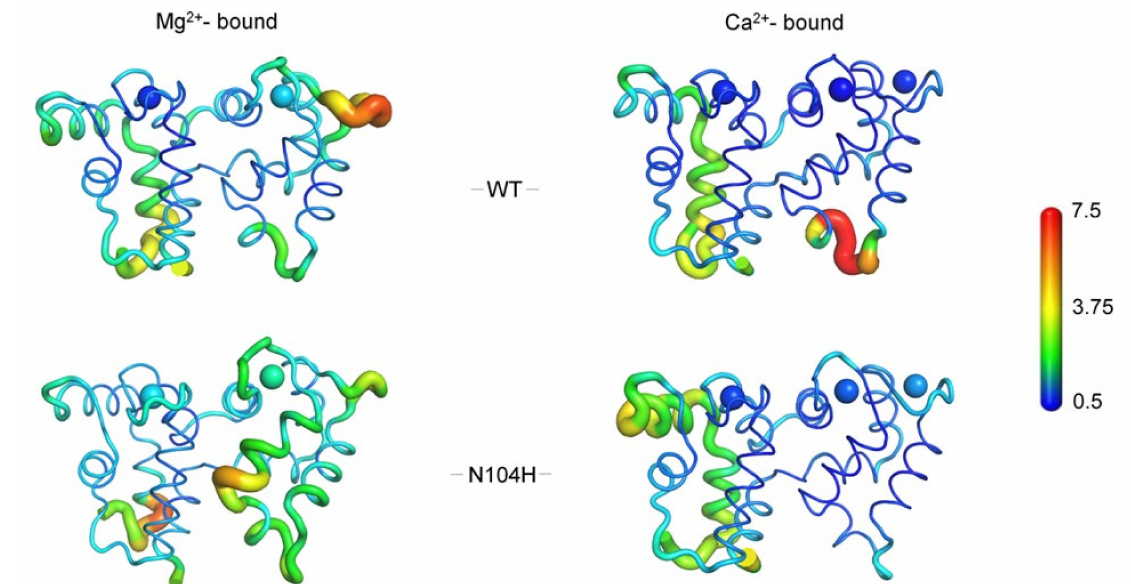
Figure 9. C α Root-Mean Square Ffluctuation (RMSF) projected on the 3D structure of WT (upper panels) and N104H (lower panels) GCAP1 in their GC-activating Mg 2+ -bound (left panels) and inhibiting Ca 2+ -loaded (right panels) forms. Protein structure is displayed as tube cartoons, with radius proportional to the RMSF; Mg 2+ and Ca 2+ are depicted as spheres. Structures and ions are colored in a rainbow scheme representing RMSF values ranging from 0.5 to 7.5 Å (see Supplementary Figure S3 for C α -RMSF